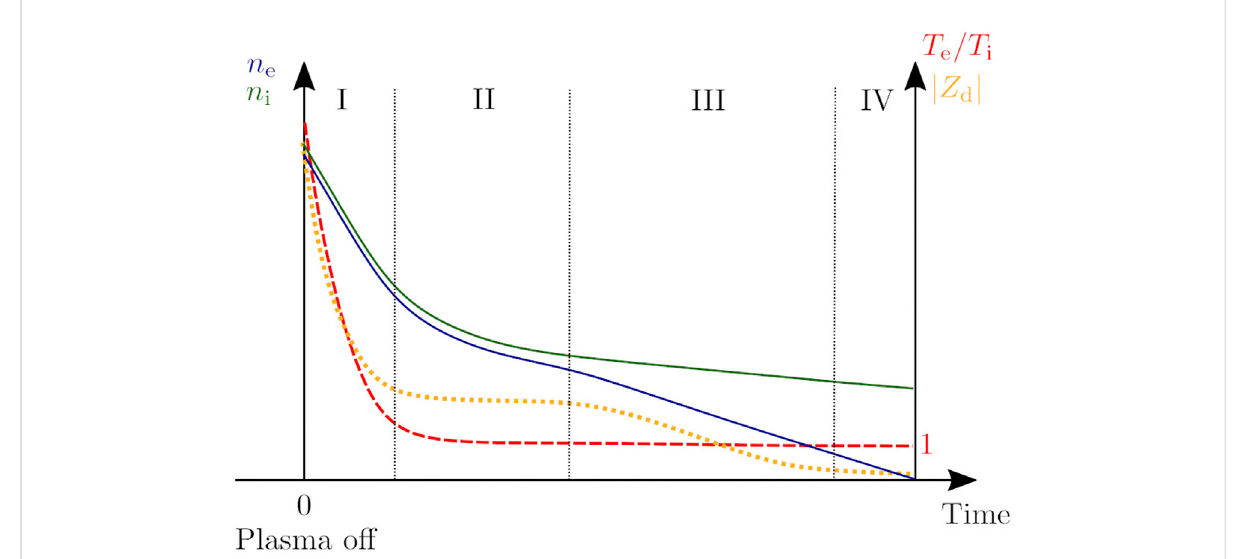
FIGURE 1 (Color on-line) Illustration of the evolution of the plasma parameters and dust charge during the afterglow. The different stages are as follows. Stage I: temperature relaxation; stage II: plasma density decay determined by ambipolar diffusion; stage III: transition to free diffusion; stage IV: frozen